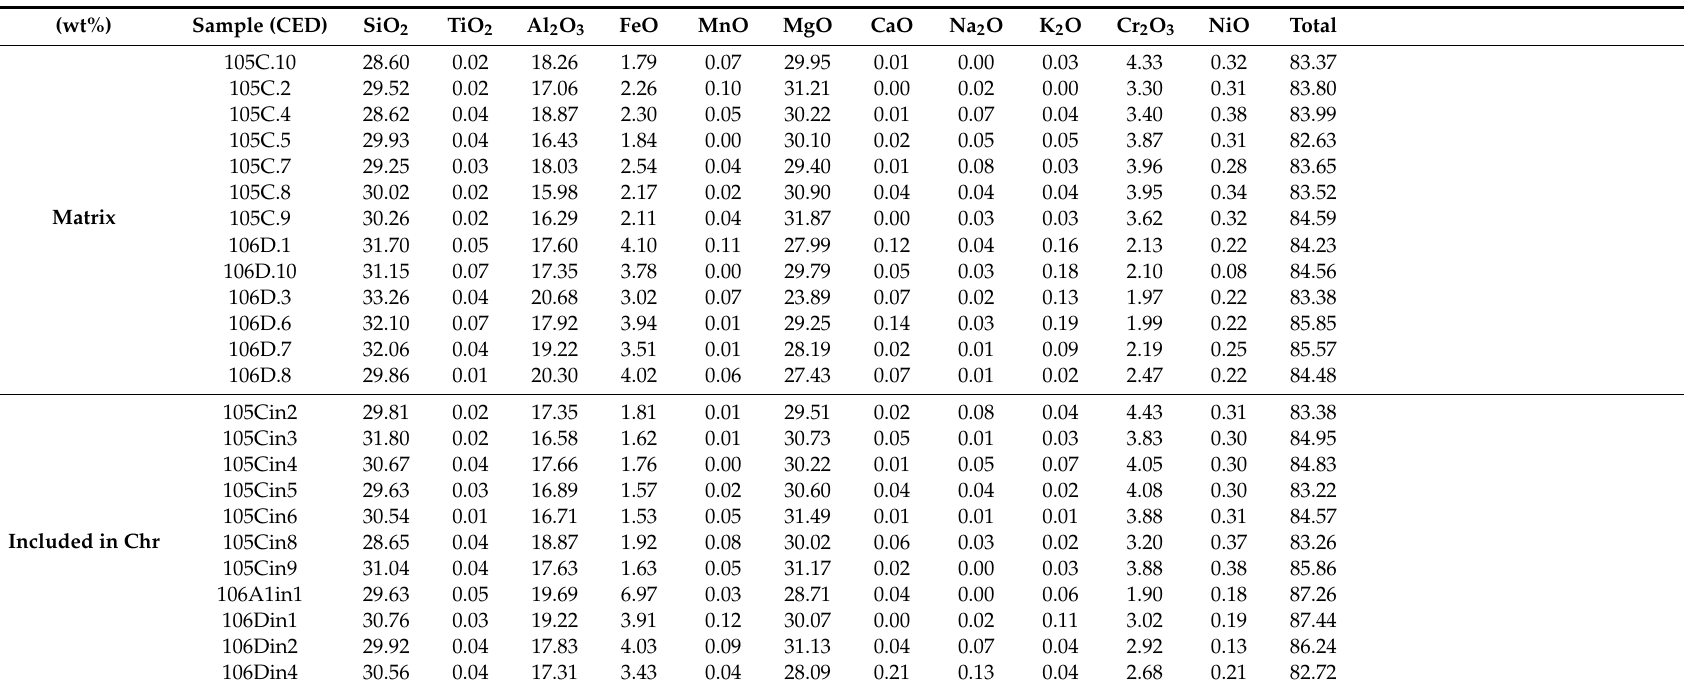
Table 2. Chlorite electron microprobe data and geothermic